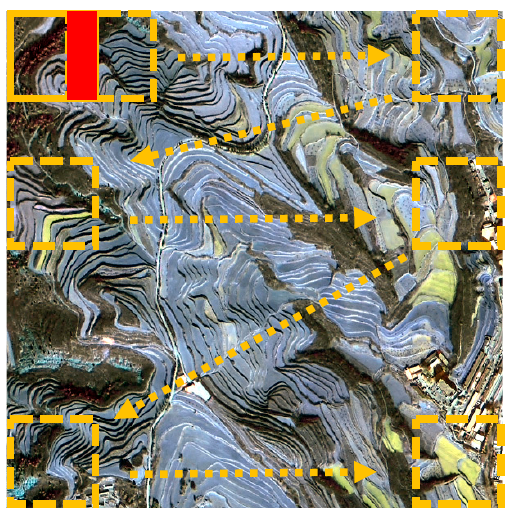
Figure 2. Schematic diagram of overlapping sliding window cropping. The yellow box is the sliding window, 256 × 256 pixels in size. The yellow arrow is the sliding track. The red area is the overlapping area.